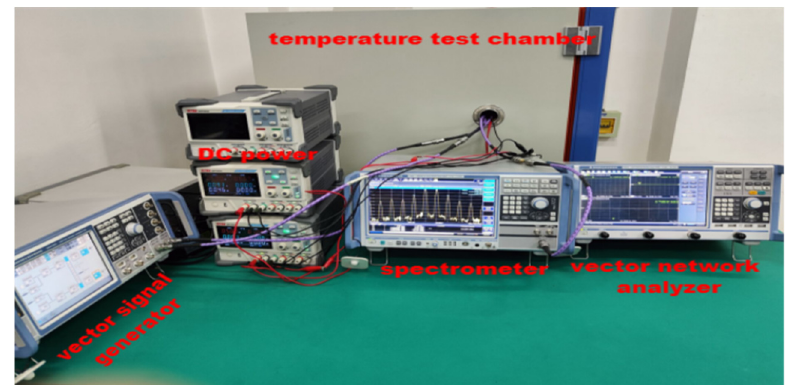
Figure 4. Experimental environment for this MMIC LNA.